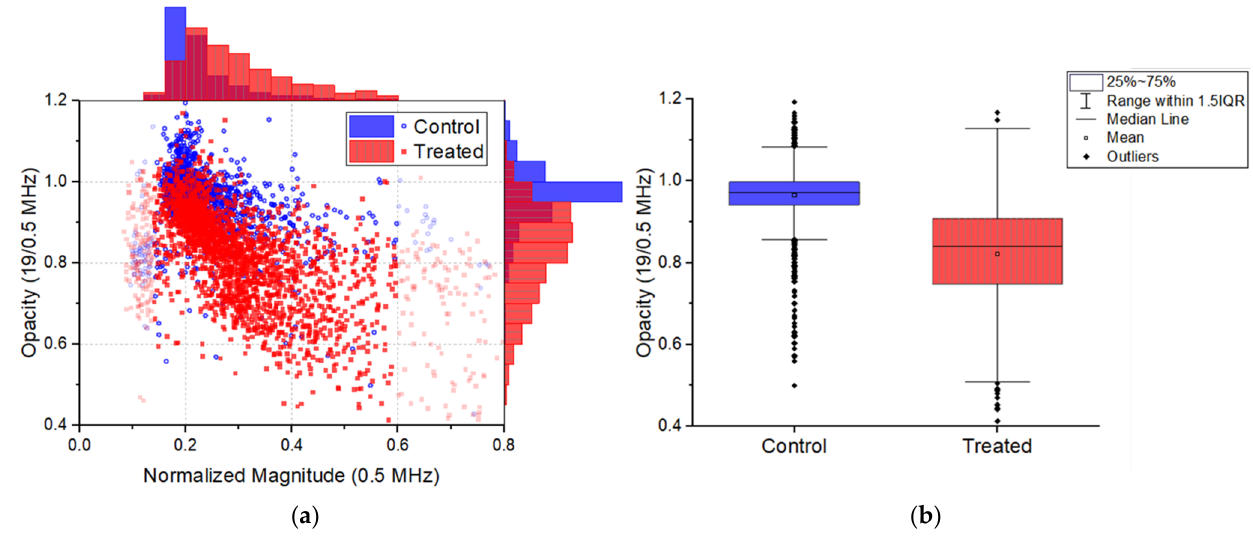
Figure 3. ( a ) Normalized magnitude vs. opacity and the corresponding histograms for all control ( ( ) and treated ( (cid:4) ) samples. The transparent data points are considered debris or double cells. ( b ) Mean opacity for control and treated sample. Significance level p < 0.001, based on the Welch’s t-test. See Supplementary Information Figure S1 for normalized magnitude vs. opacity and normalized magnitude vs. phase for all individual samples.